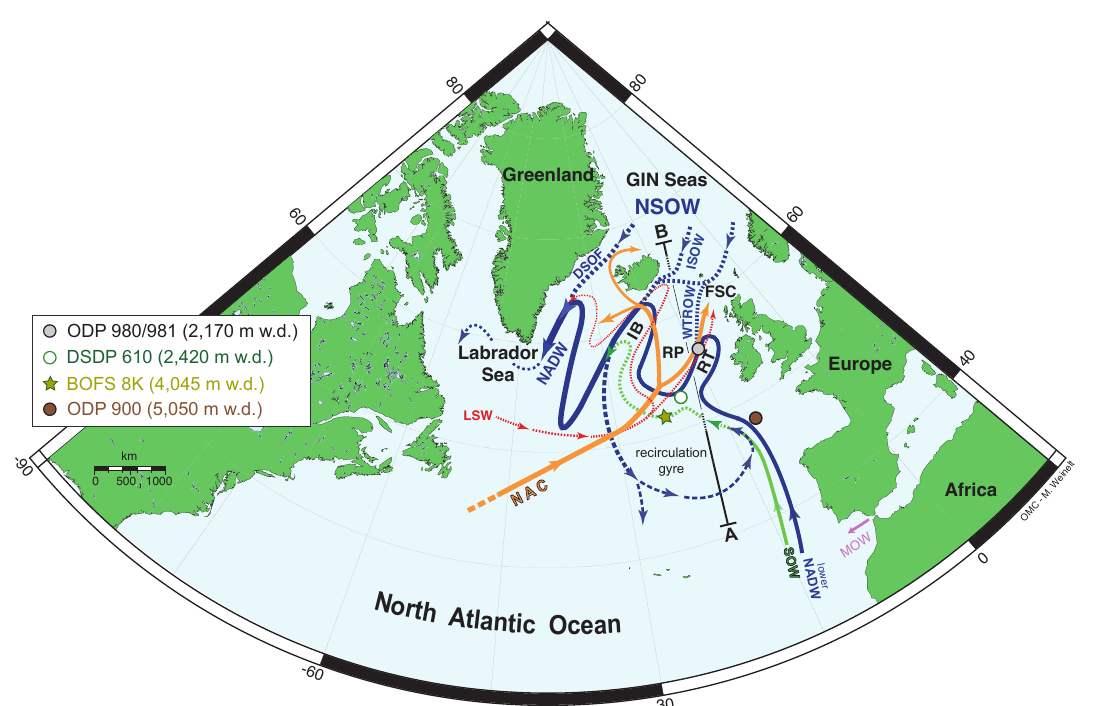
Figure 1. Circulation pattern in the modern North Atlantic with locations of study sites and core BOFS 8K (adopted from Manighetti and McCave, 1995). Nordic Seas overflow water (NSOW) consists of Iceland–Scotland, Denmark Strait, and Wyville Thomson Ridge overflow water (ISOW, DSOW, and WTROW, respectively). Southern Ocean water (SOW) and overlying lower (old) NADW mix with NSOW south of Iceland Basin (IB). A branch of this water mass flows back to form a cyclonic recirculation gyre south of the Rockall Plateau (RP). Dashed arrows indicate overflow pathways: NAC – North Atlantic Current, GIN – Greenland–Iceland–Norwegian, NADW – North Atlantic deep water, LSW – Labrador Sea Water, and MOW – Mediterranean outflow water. Cross-section (A–B) shows water mass distribution in the modern northeast Atlantic (see Fig. 2).